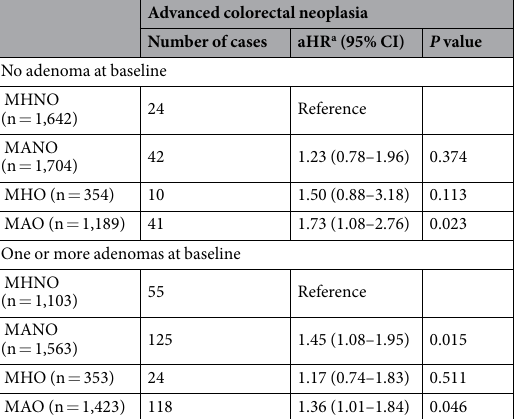
Advanced colorectal neoplasia aHR a (95% CI) P value